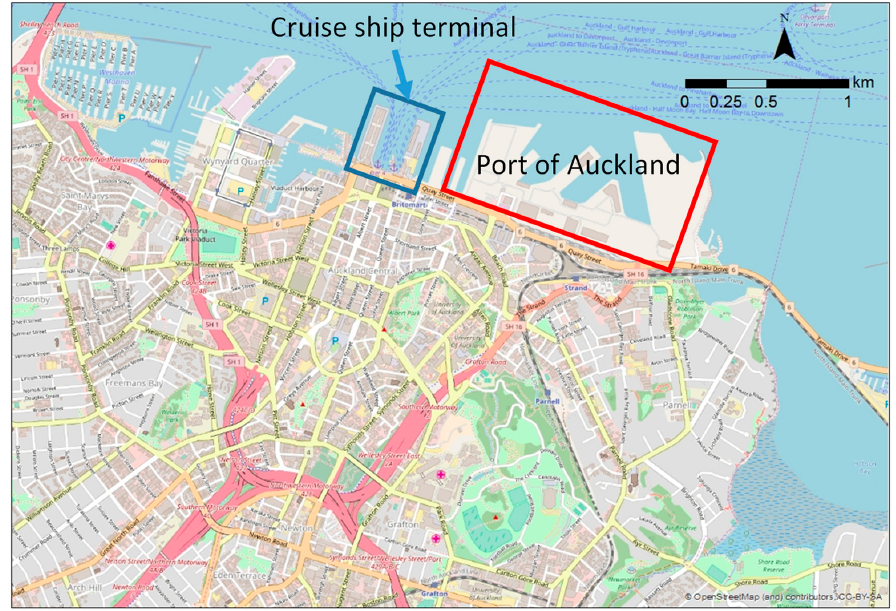
Figure 1. The Auckland central business district (CBD) is surrounded by motorways to the west, south, and east, and the waterfront to the